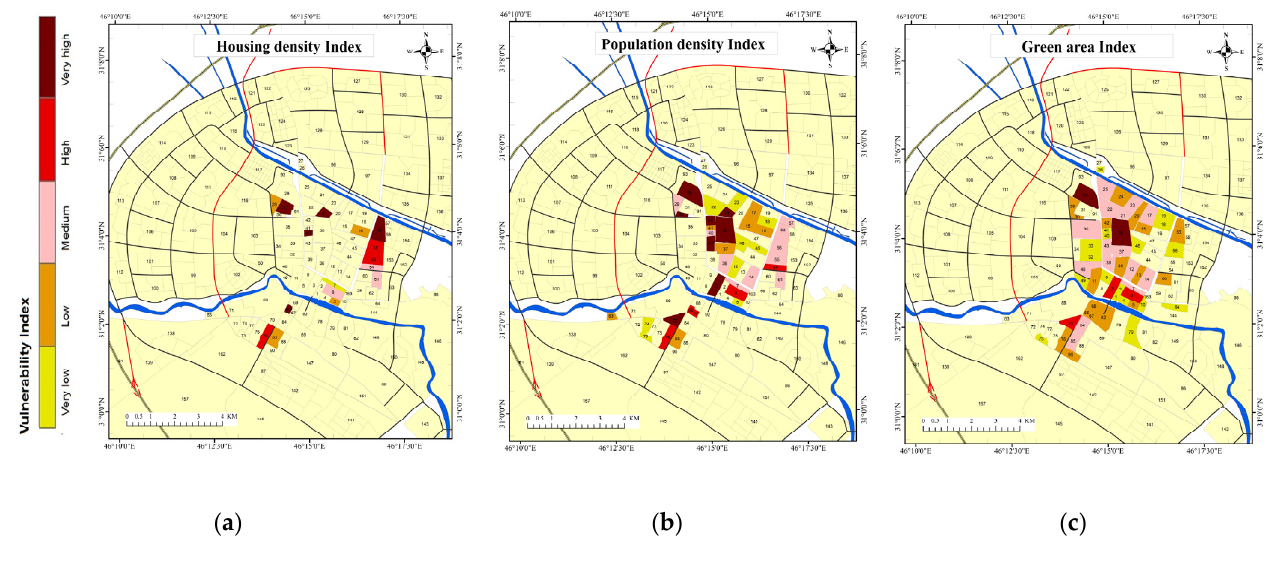
Figure 11. Sub-criteria of the urban domain: ( a ) dwelling density (C7), ( b ) population density (C8) and ( c ) green space ratio (C9).